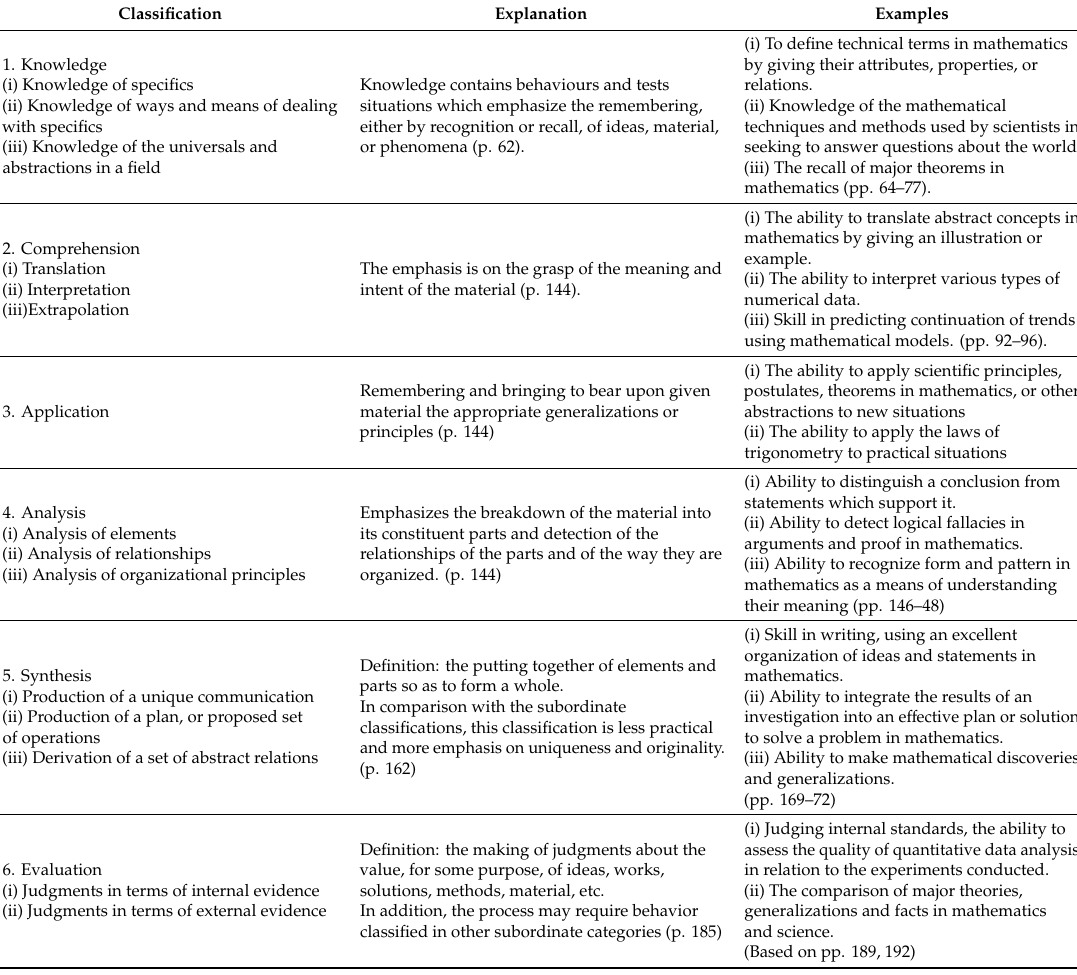
Table 1. Summary of Bloom’s original taxonomy (1956) with mathematics application